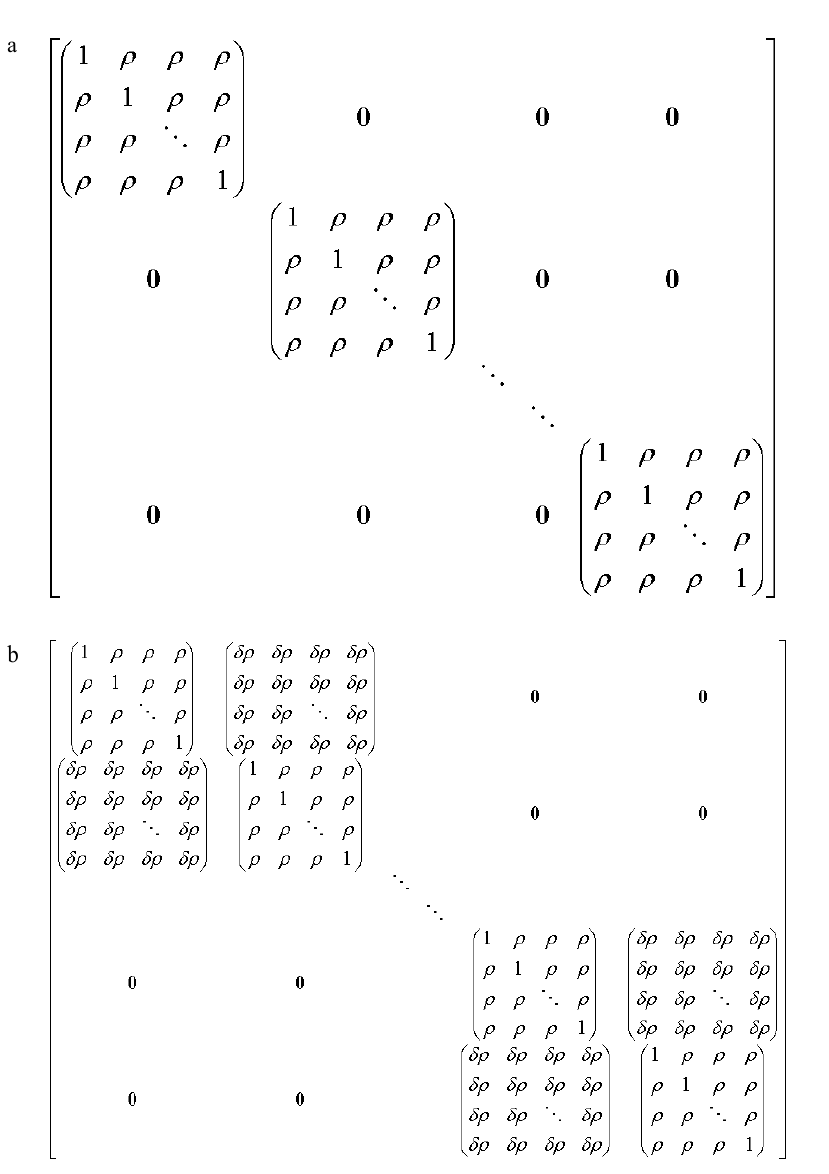
Figure 1. ( a ) Compound symmetric correlation structure assumed for design with one female per litter bred. The correlation between any two pups in a litter was assumed to be ρ . ( b ) Correlation structure assumed for design with two females per litter bred. The correlation between any two pups in a litter was assumed to be ρ , and the correlation between any two pups from litters of related females was assumed to be δρ where 0 < δ ≤